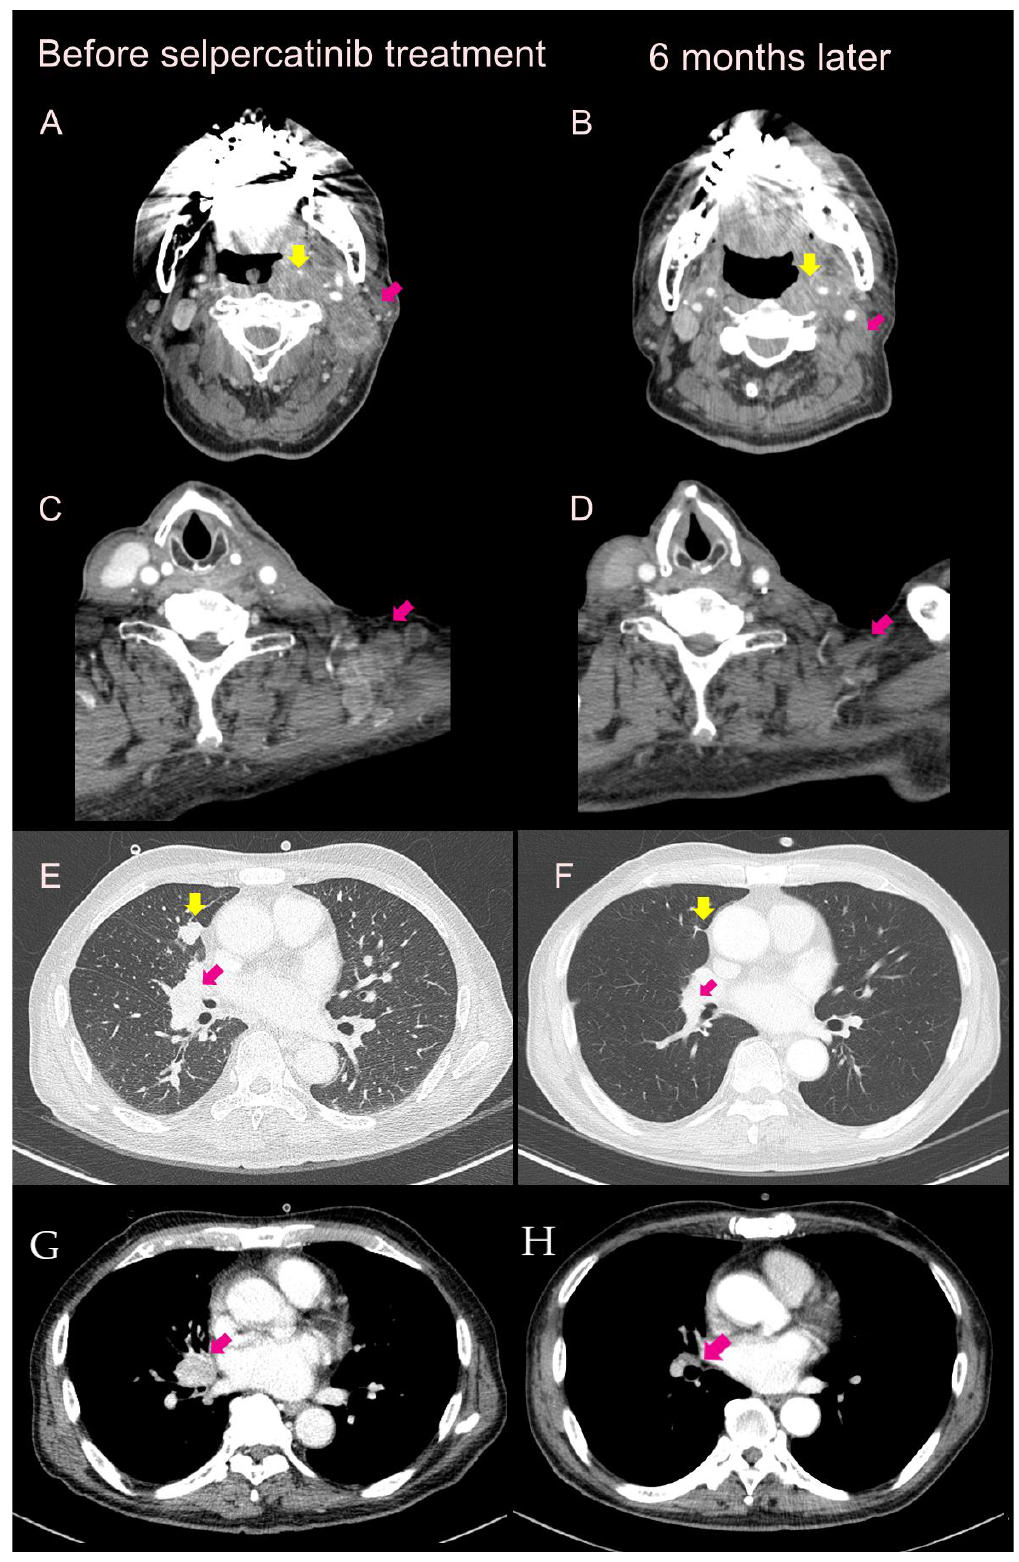
Figure 1. CT scan images of the Case 1 patient before and at six months after selpercatinib treatment. Before selpercatinib treatment, there were metastatic lesions at the neck ( A ); lateral lymph node ( C ); lung parenchym ( E ); and hilar lesion ( G ). All of them showed regression at six months after selpercatinib treatment ( B , D , F , H ) (yellow and purple